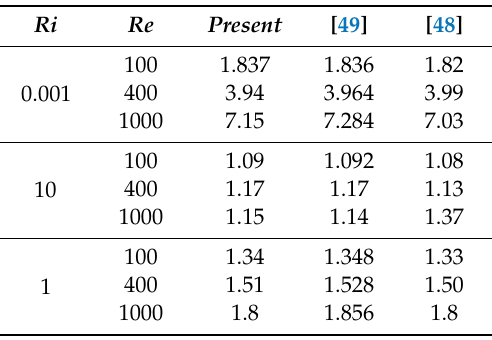
Table 3. Comparison of averaged Nusselt number at the top wall. Ri Re Present